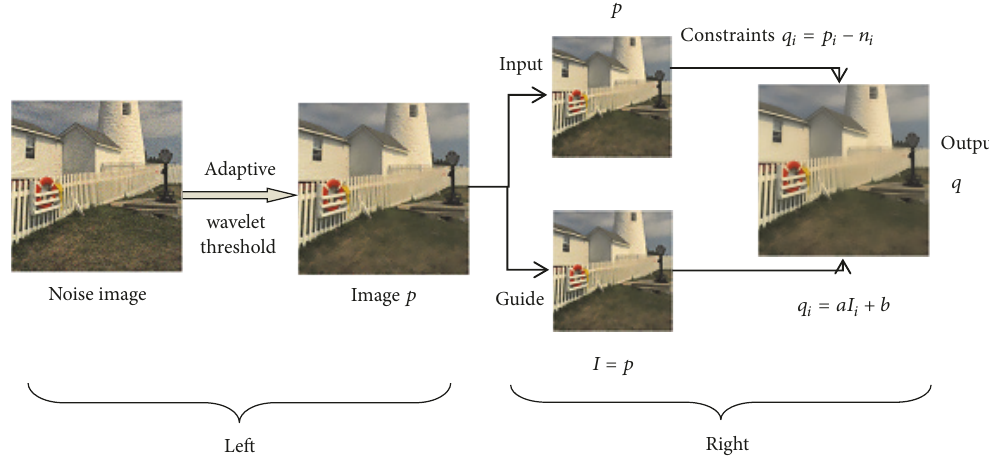
Figure 1: Illustration of the proposed method. It contains two main parts. Left part is denoising by adaptive wavelet threshold algorithm to obtain denoise image 𝑝 . Right part is using guided filter to enhance edges of image 𝑝 .